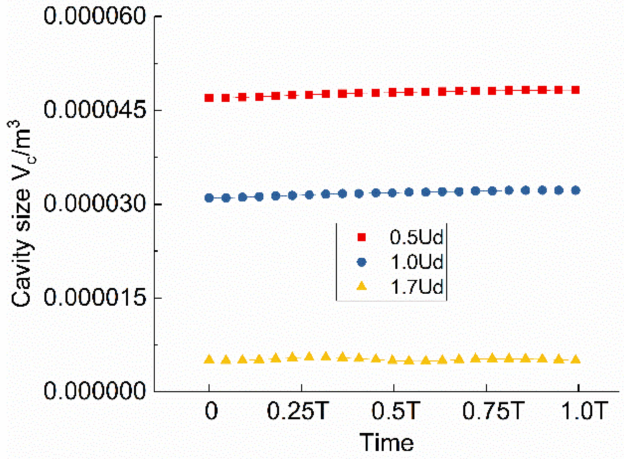
Figure 24. The cloudy cavity size at different cruising speeds.